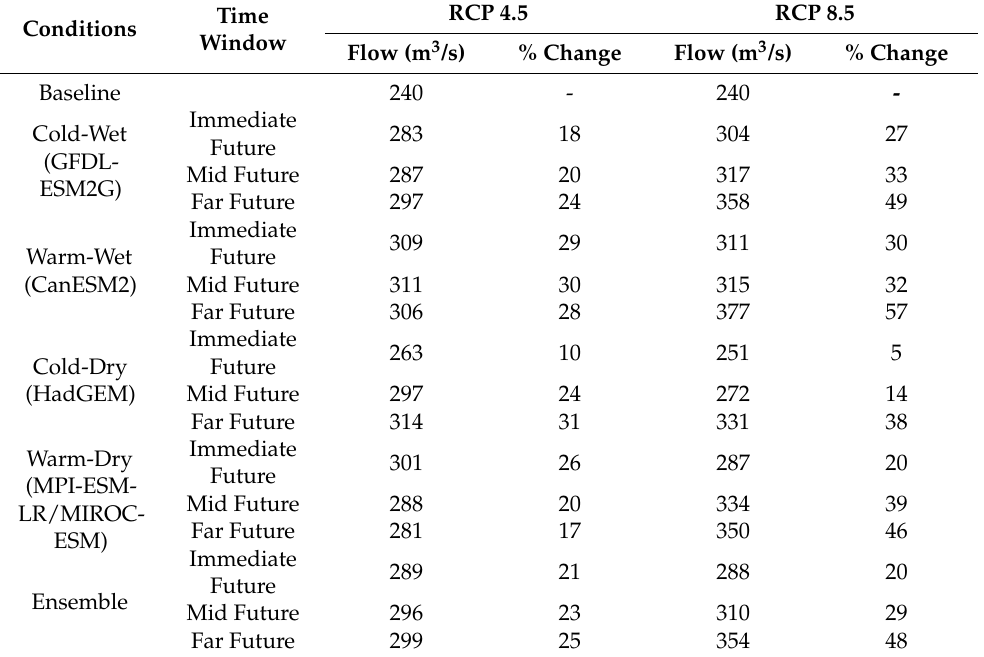
Table 2. Impact of climate change on long-term annual